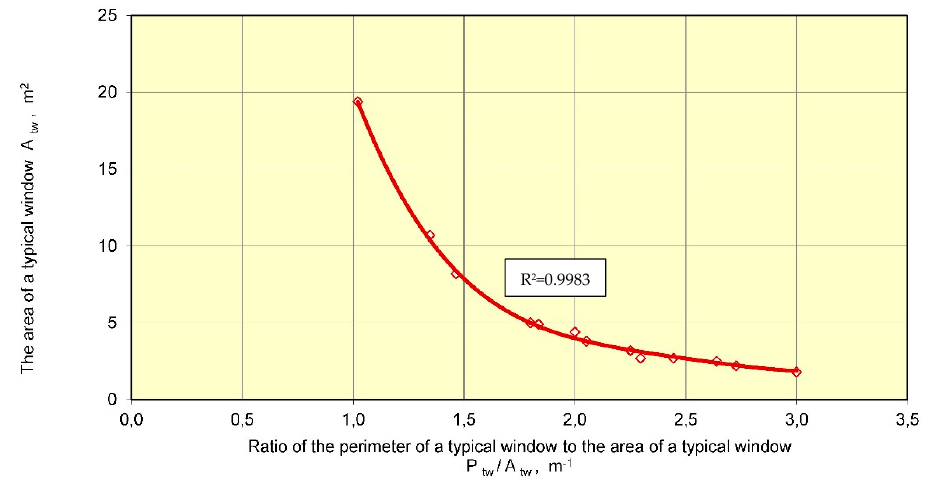
Figure 7. Relations between the area of a typical window A tw and the ratio of the perimeter of a typical window P tw to the area of a typical window A tw in education buildings.